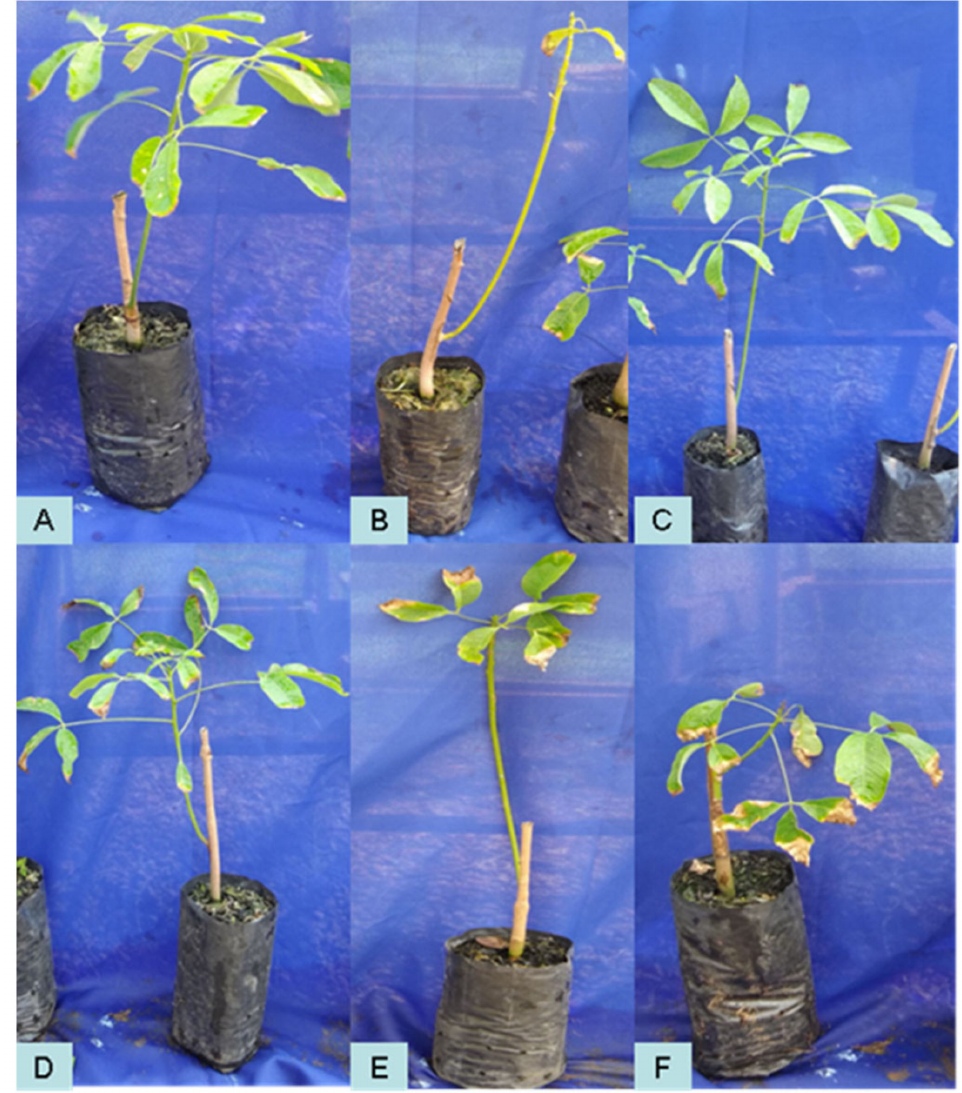
Figure 4. Seedlings of the rubber tree clone RRIM600 after preventive treatments with water ( A ), Colletotrichum alone ( B ), P. macrosporus —Isolate 37/06 ( C ), C. eragrostidi —Isolate 47/06 ( D ), M. levis- pora —Isolate 33/08 ( E ), and M. roridum —Isolate 03/10 ( F ). Table 3. Activity of the enzyme PAL in rubber tree seedlings after curative treatments with sapro- bic